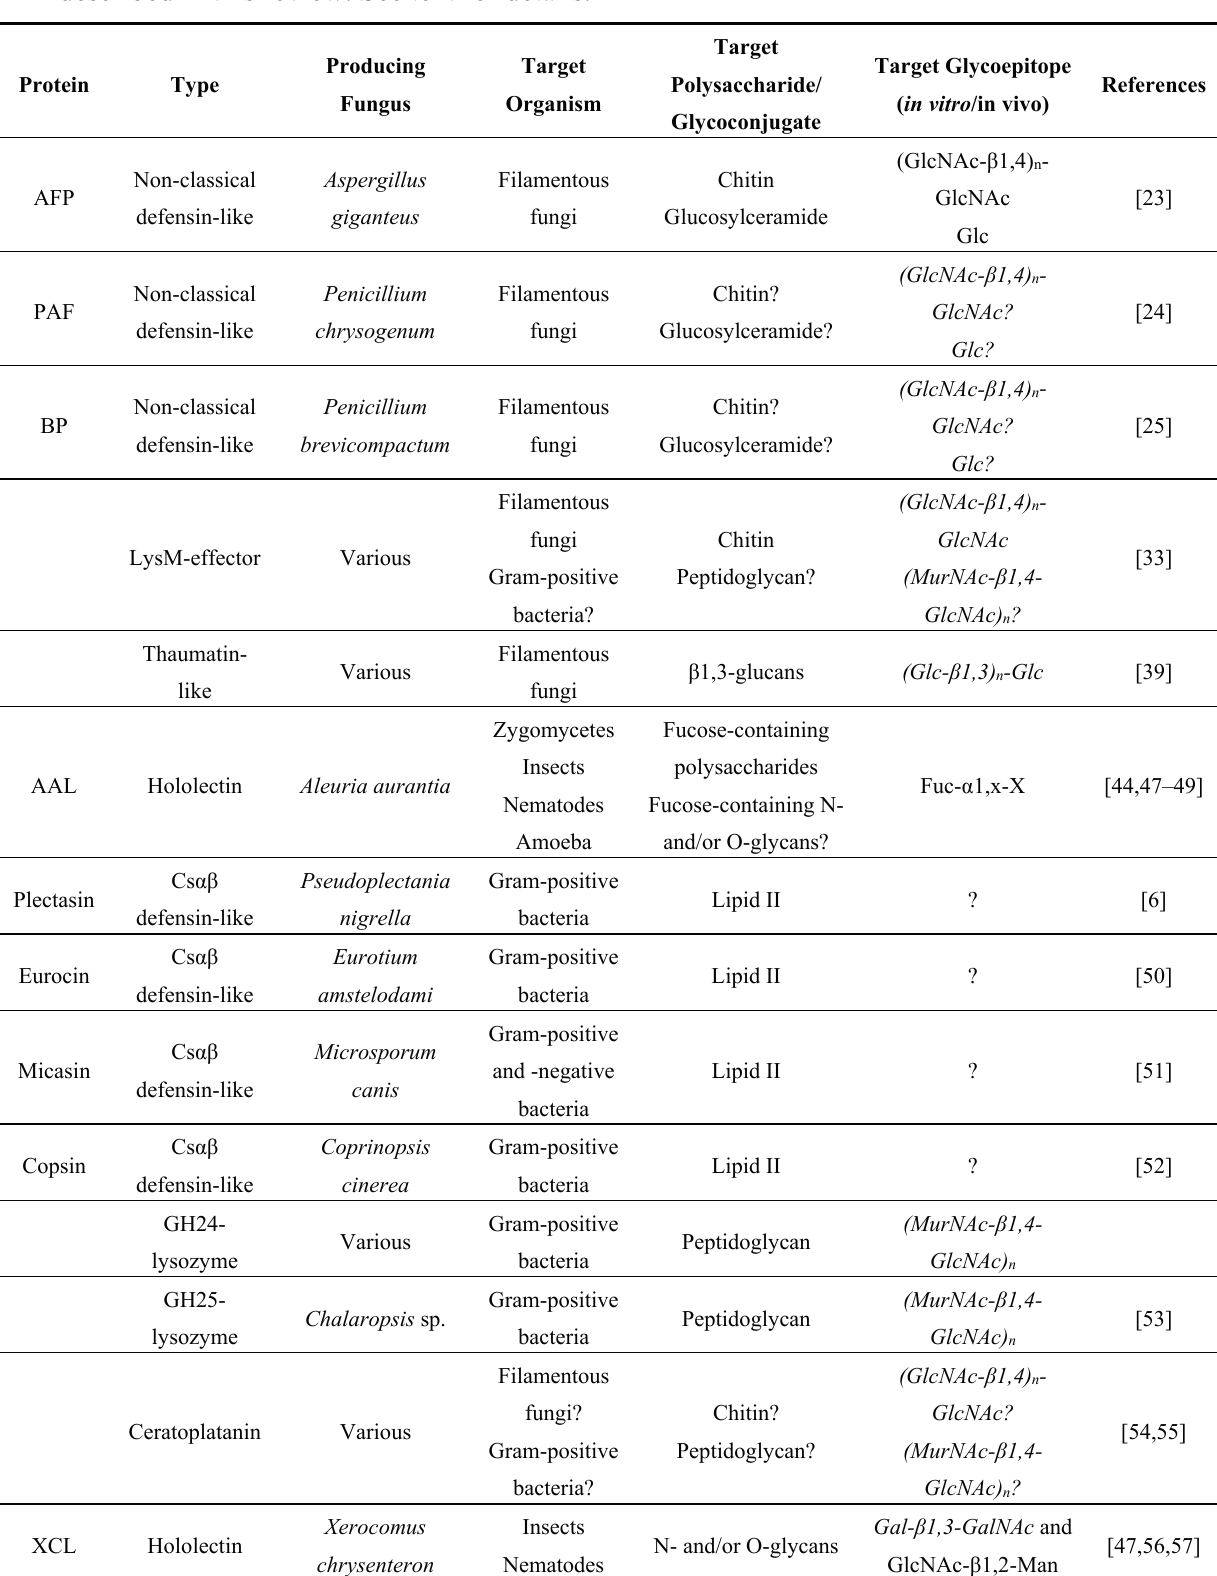
Table 1. List of characterized and hypothetical glycan-binding fungal defense proteins described in this review. See text for